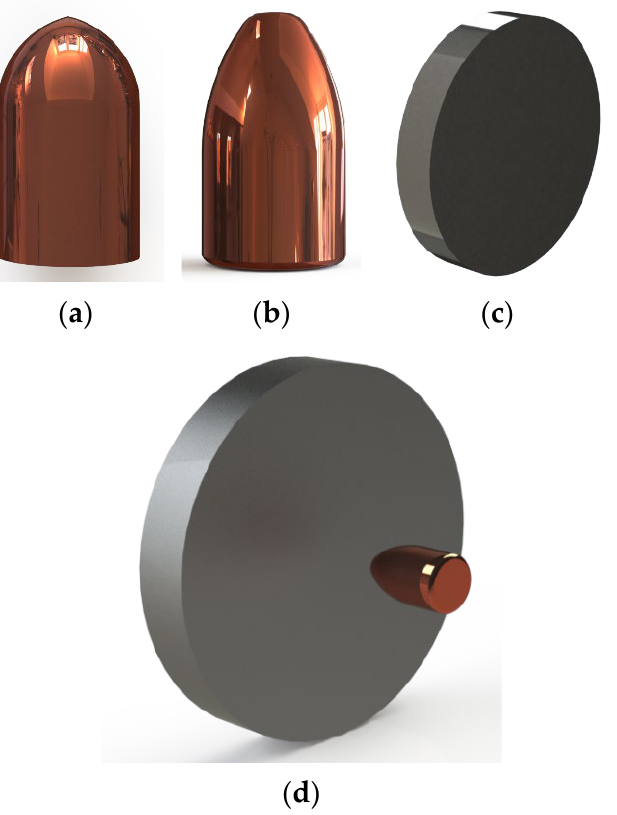
Figure 2. The 3D design of simulation parts ( a ) AMMO 1; ( b ) AMMO 2; ( c ) firing target; and ( d ) part assembly.